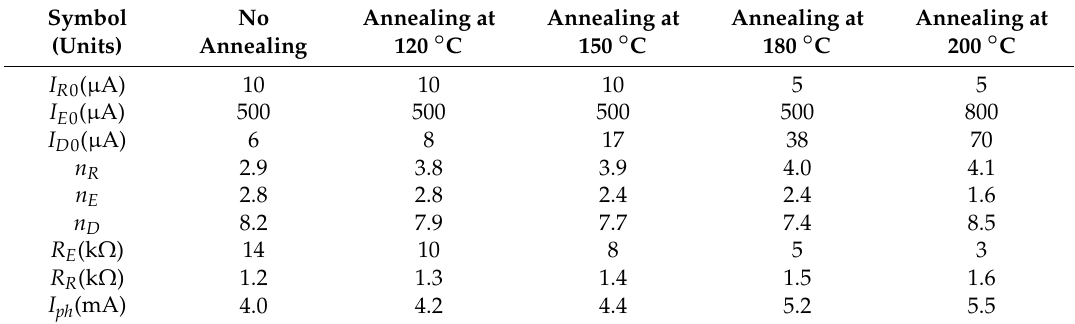
Table 1. Model parameters used in simulations of our improved circuit in Figure 2.